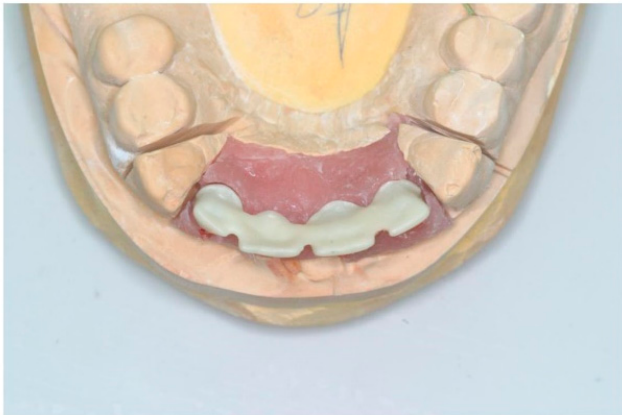
Figure 4. The zirconia base framework.